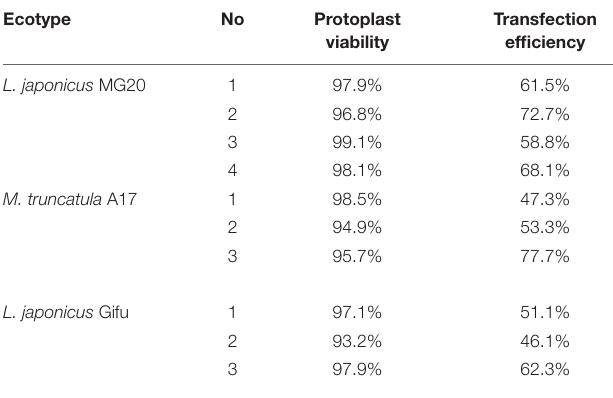
FIGURE 2 | Isolation of protoplasts from legumes roots. Isolated root protoplasts from (A) 6-day-old L. japonicus MG20 seedling. (C) 8-day-old